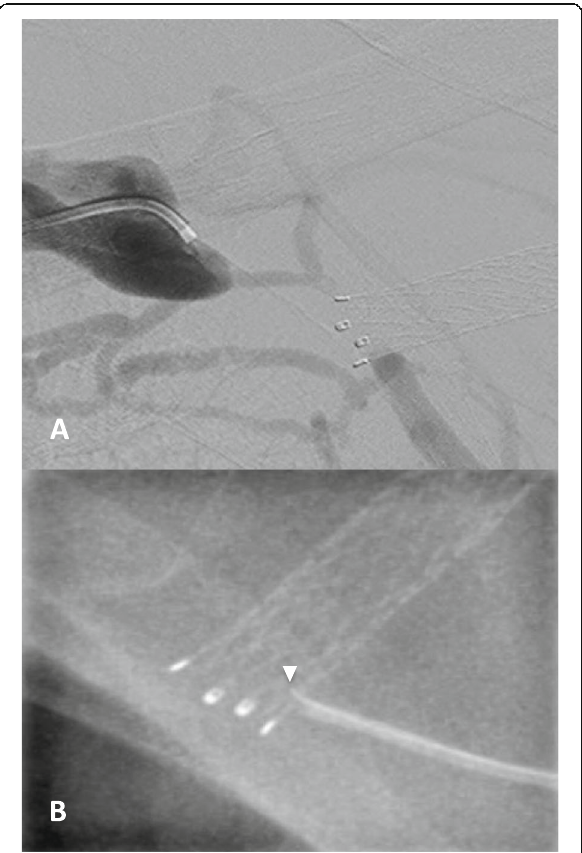
Fig. 2 a Venogram showing short segment occlusion of the subclavian vein from the protruding cephalic arch stent graft. b Attempted antegrade wire crossing with the Winn 200 T wire (arrowhead), which was unable to penetrate through the stent graft fabric via the antegrade